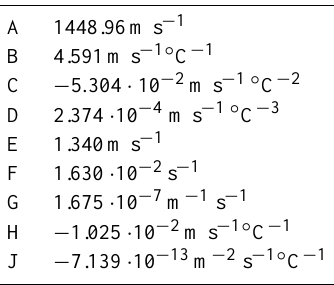
Table 1. Sound speed has been computed for each grid point and for each month of the MED6 data set, and from this field the annual average was also